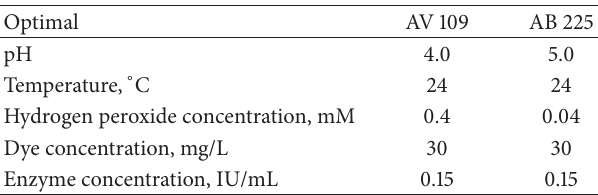
Table 3: Optimal parameters for examined anthraquinonic dyes decolorization by